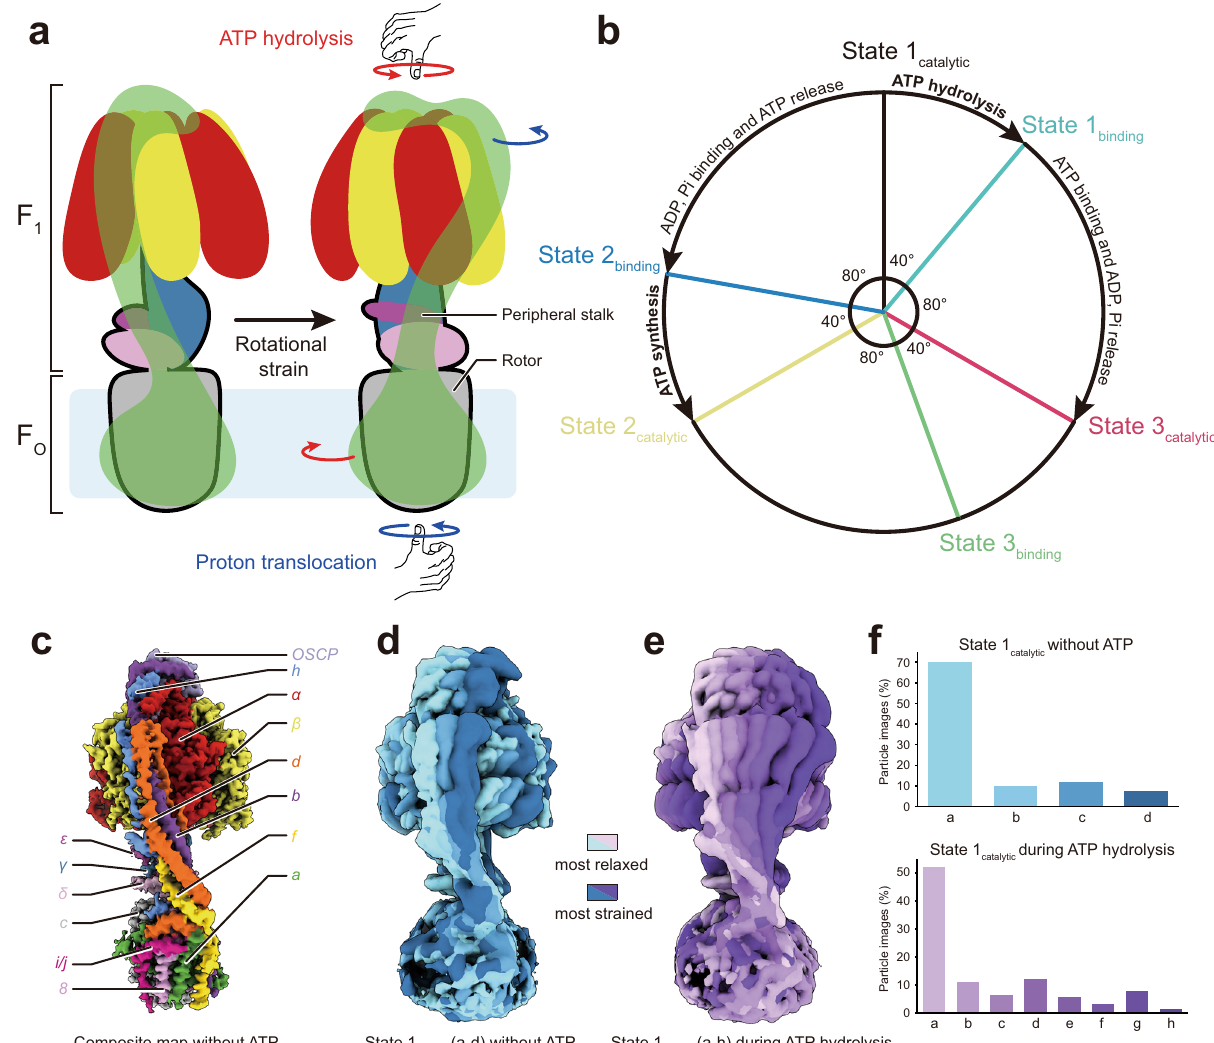
Fig. 1 Rotation in ATP synthase. a ATP synthase (left) consists of an F 1 and an F O region with a shared rotor subcomplex (outlined in black) and a peripheral stalk (green). Rotation driven by proton translocation through the F O region, or the opposite rotation driven by ATP hydrolysis in the F 1 region, are predicted to induce a right-handed bend of the peripheral stalk (right). b ATP hydrolysis or synthesis in the F 1 region requires three catalytic (black, yellow, and red) and three bind dwell (light blue, blue, and green) conformations. c High-resolution structure of the yeast mitochondrial ATP synthase. d In the absence of free ATP, the peripheral stalk exhibits limited fl exibility with a left-handed curvature. e During ATP hydrolysis, ATP synthase can adopt conformations that show a right-handed curvature of the peripheral stalk. f Histograms of the distribution of conformations in the absence of ATP (top, blue) and during ATP hydrolysis (bottom,